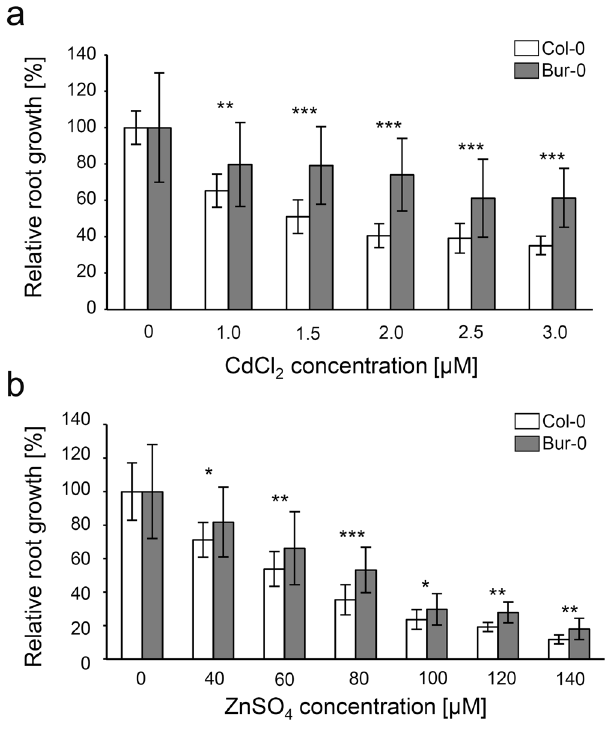
Figure 2. Accessions Col-0 and Bur-0 differ in their root growth response to toxic concentrations of Zn 2 + and Cd 2 + . Col-0 (white bars) and Bur-0 (grey bars) seedlings were grown on vertical agar plates under control conditions (0 µ M extra metal added) or in the presence of either varying concentrations of CdCl 2 ( a ) or ZnSO 4 ( b ) Relative root growth of seedlings as an indicator for tolerance was calculated as follows: root length metal treatment/mean root length control conditions × 100. In ( a ) absolute root lengths (in mm) under control conditions were: for Col-0 84 ± 7.6, for Bur-0 80 ± 24.1. Data represent means ± SD of 40–70 individuals grown in two independent experiments. In ( b ) absolute root lengths (in mm) under control conditions were: Col-0 85 ± 15, Bur-0 96 ± 27. Data represent means ± SD of 18–74 individuals grown in 2–4 independent experiments. Significant differences between accessions are indicated by asterisks ( *** P < 0.001; ** P < 0.01; * P < 0.05) and were calculated by one-way ANOVA and subsequent Tukey test, 95% confidence